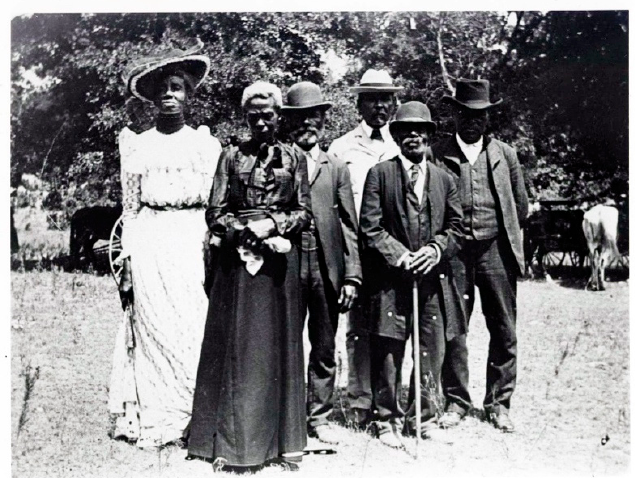
Figure 6. Emancipation Celebration on 19 June 1900. Image from the Austin History Center, Austin Public Library, courtesy of Mrs. Charles Stephenson (Gracy Murray).